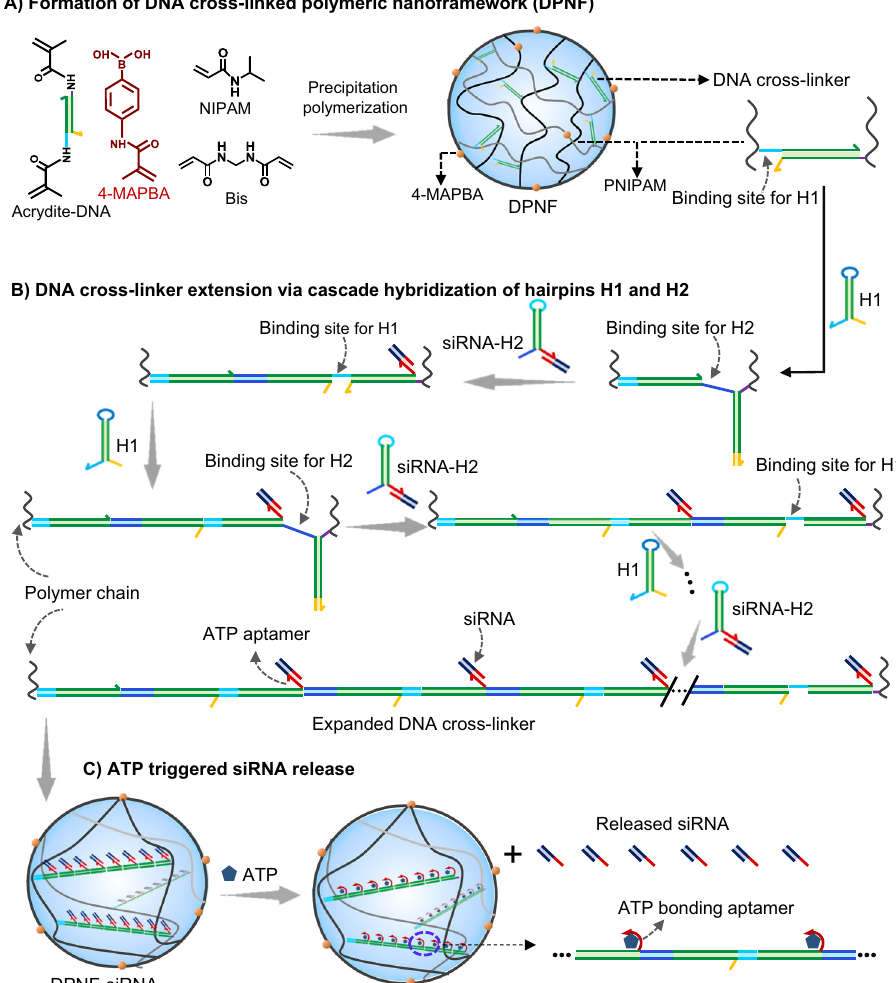
Fig. 1 Molecular design. Schematic diagram of A the preparation of DPNF, B DNA cross-linker extension for siRNA loading via cascade hybridization of DNA hairpins in DPNFs, and C ATP-triggered release of siRNA from DPNFs. NIPAM, N-isopropylacrylamide; 4-MAPBA, (4-methacrylamidophenyl) boronic acid; Bis, N,N-methylene diacrylamide; PNIPAM, Poly(N-isopropylacrylamide); ATP, triphosadenine. The single strands with same color in H1 and H2 are complementary